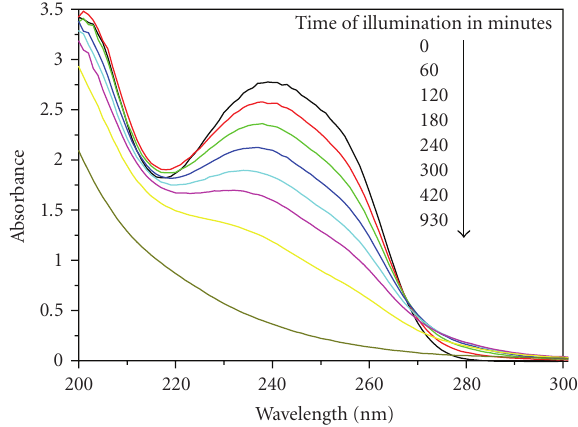
Figure 2: Absorption spectrum of AZS in water and variation with time of UV illumination in the presence of TiO 2 nanocrystalline films.